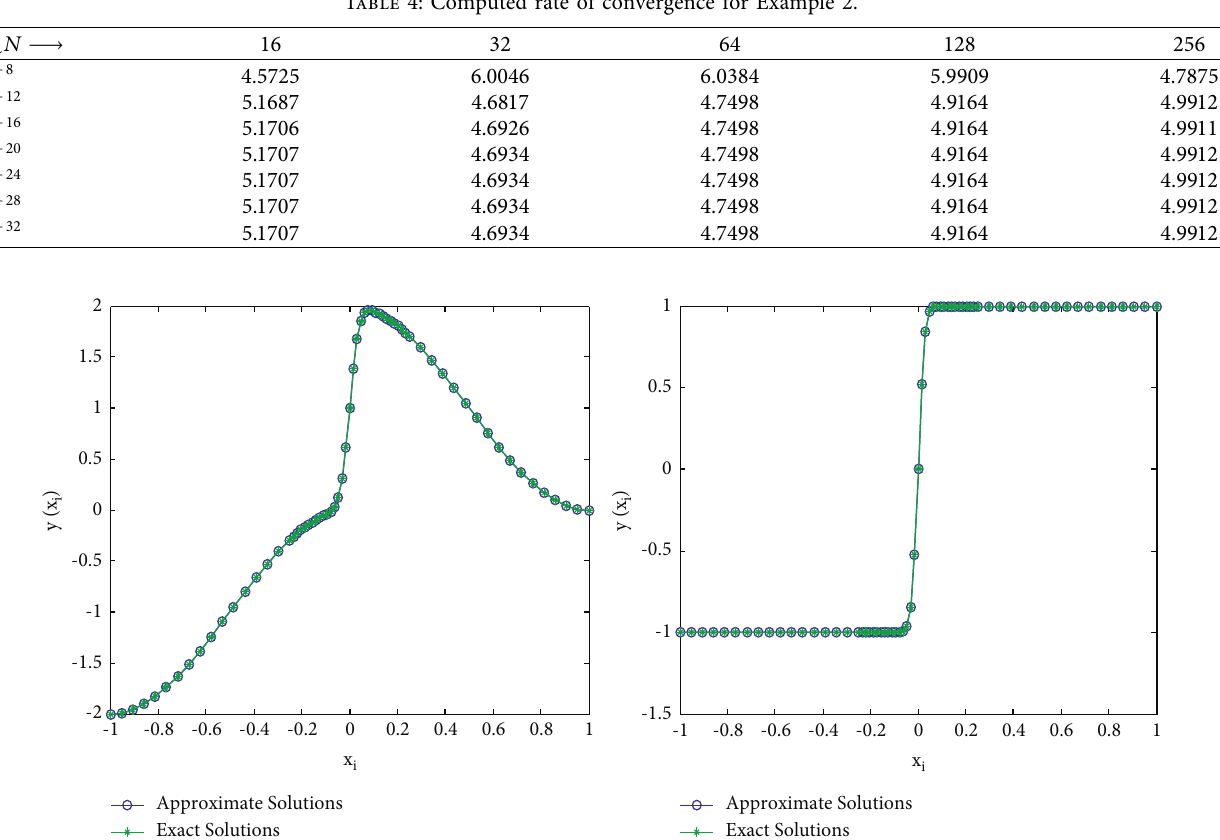
Figure 1: Graphs of approximate and exact solutions for Examples 1 and 2 respectively, when ε � 2 − 10 and N � 64.